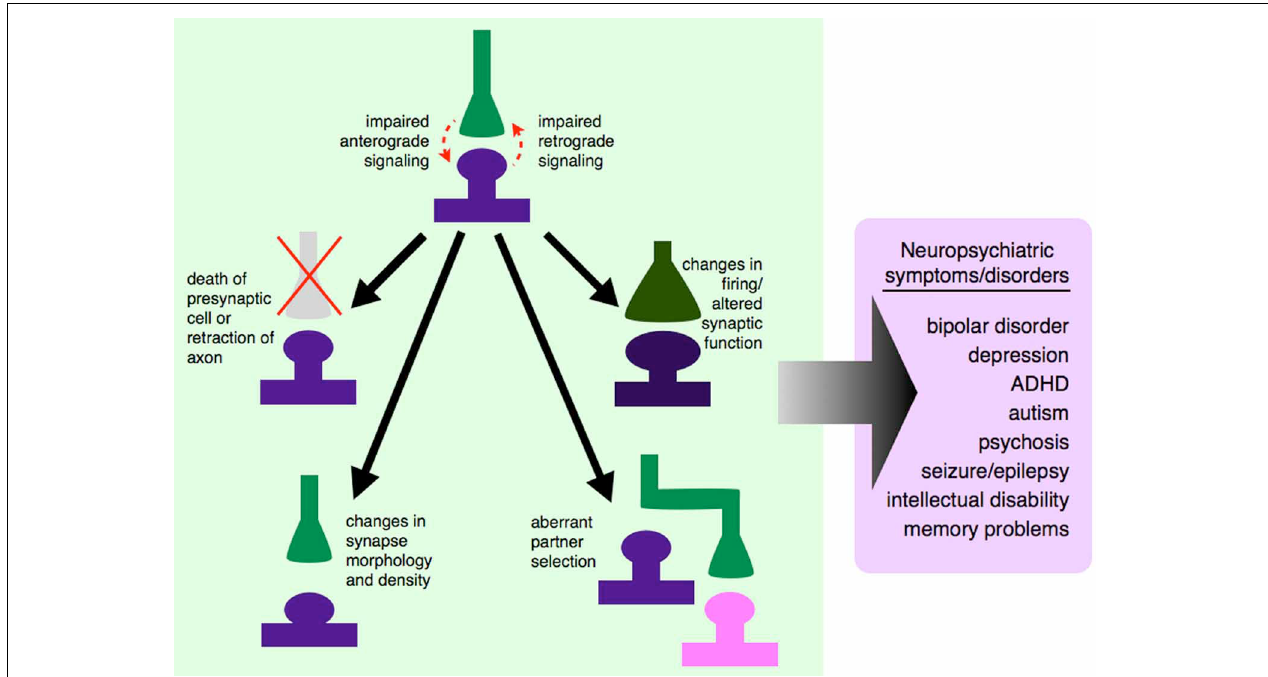
FIGURE 1 | Dysregulated growth factor signaling can lead to synaptic-level defects and neuropsychiatric disease. Synaptogenic growth factors signal in both anterograde and retrograde directions, depending on the specific growth factor involved. If this signaling is disrupted, due to genetic mutations, changes in expression level, or changes in secretion pattern, synapses will not be established properly. Some growth factors exert trophic functions at the level of the synapse, and dysregulated signaling could lead to the death of the presynaptic cell or retraction of that axon from its appropriate postsynaptic partner. Even if the presynaptic axon is not retracted, impaired growth factor signaling between synaptic partners could cause changes in synaptic morphology and density, and ultimately to a non-functional synapse. Impaired signaling could also lead an axon to bypass